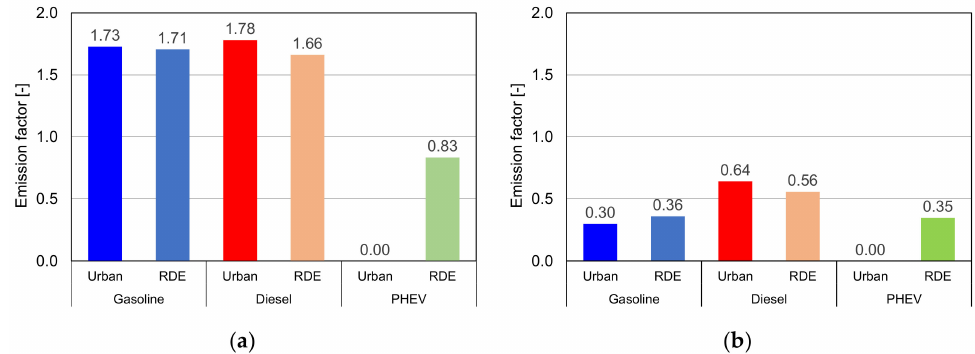
Figure 18. Emission factors (EF) for passenger cars in environmental ( a ) and health ( b )